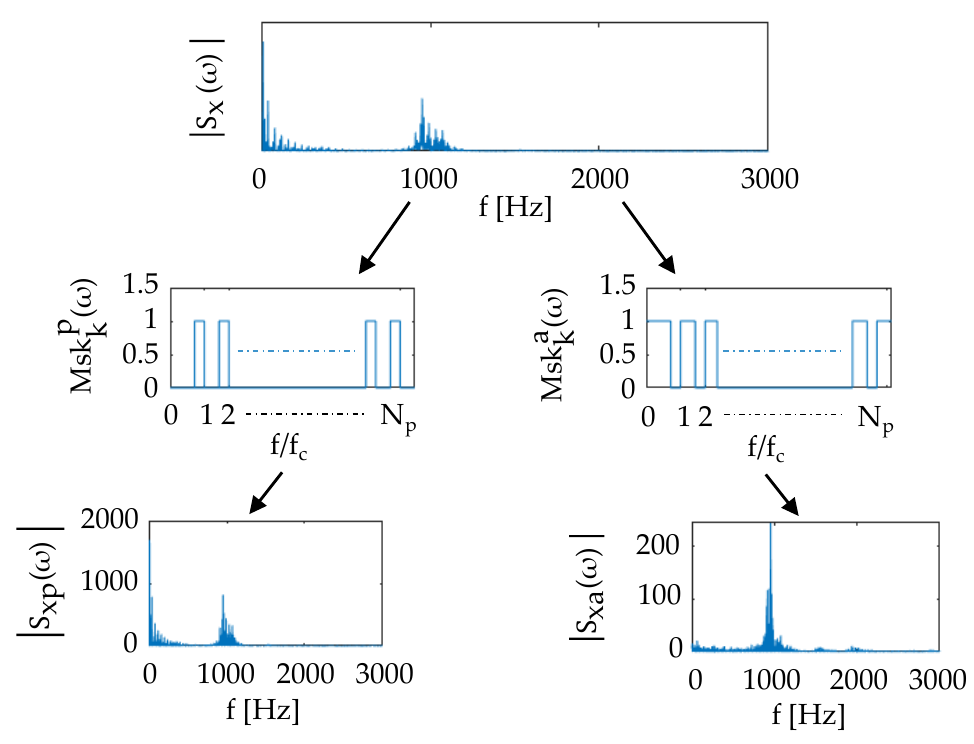
Figure 3. Separation of spectrum